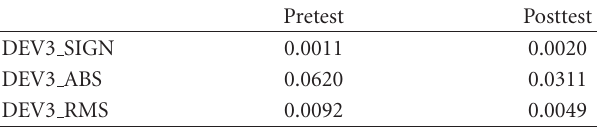
Table 3: Core- and time-averaged deviations